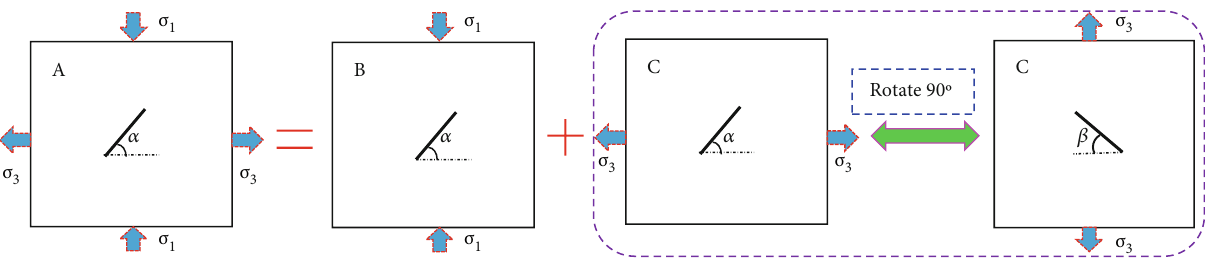
Figure 2: Secondary superposition of the stress state of a single-cracked rock mass under unloading